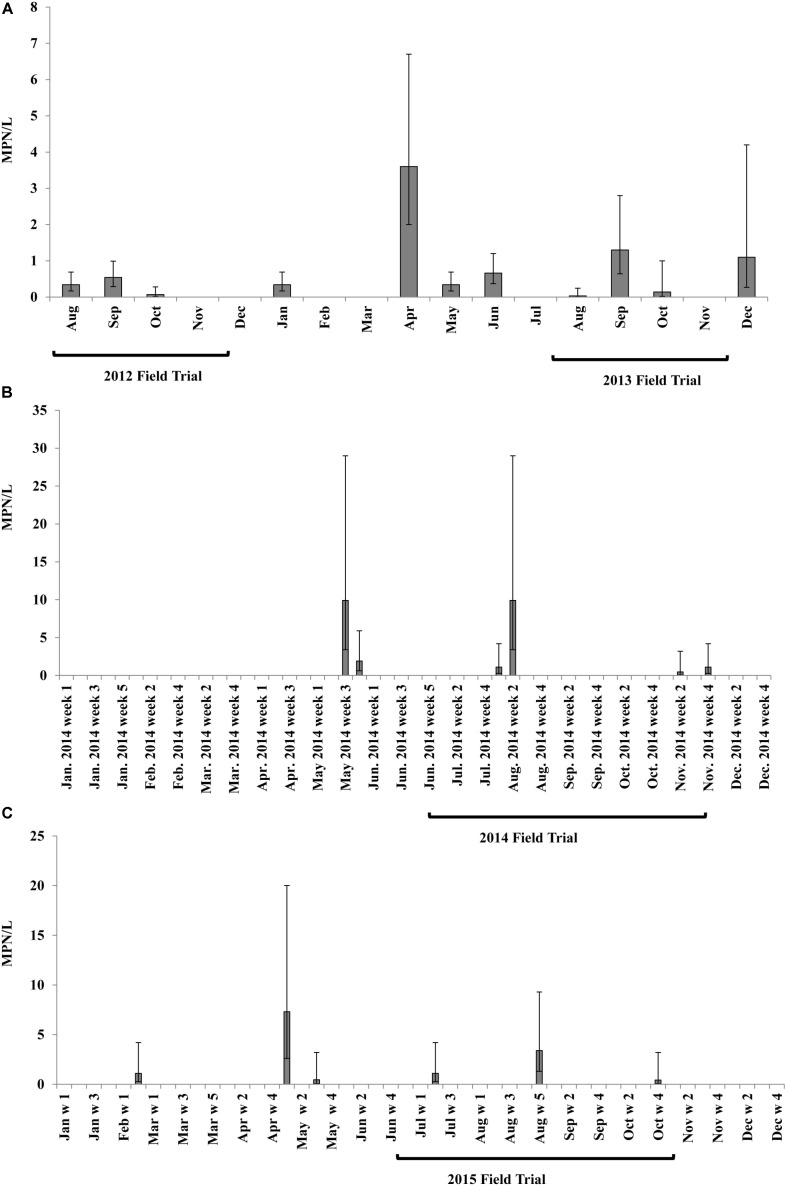
Most probable number (MPN) values of Salmonella spp. in irrigation pond water at Virginia Tech ESAREC from August 2012 to December 2013 (A) monthly detection; in 2014 (B) weekly detection; and in 2015 (C) weekly detection. Bars present 95% confidence intervals. Brackets cover the range of growth seasons of field trials performed in the 4-year study.